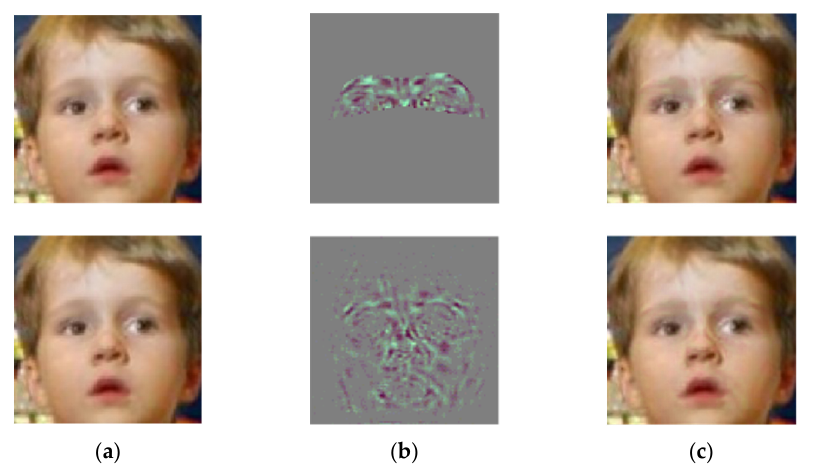
Figure 7. Schematic diagram of key point generation matrix based on eye detection. ( a ) Clean image of a child. ( b ) Adversarial perturbation based on the human eye and full face. ( c ) Adversarial examples based on the human eye and full face.